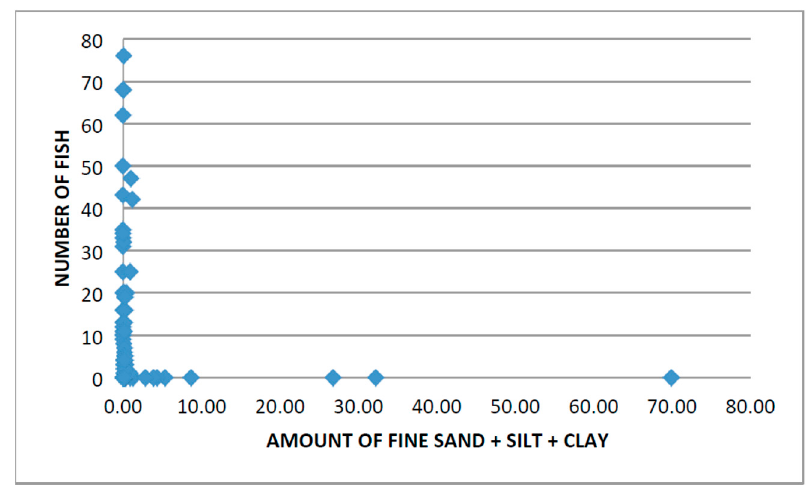
Figure 14. Number of fish in grab sample versus amount of fine sediment (grain size finer than 0.25 mm).